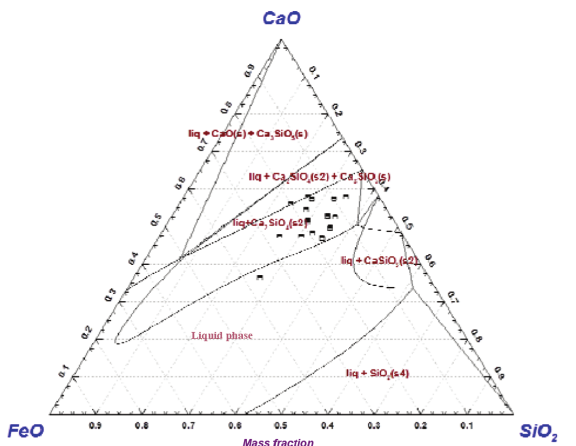
Figure 3: Composition of the slag at first deslagging in CaO – SiO 2 – FeO ternary phase diagram at 1,673 K.